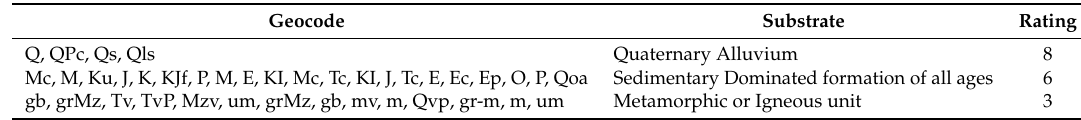
Table 3. Classification and rating values of geologic